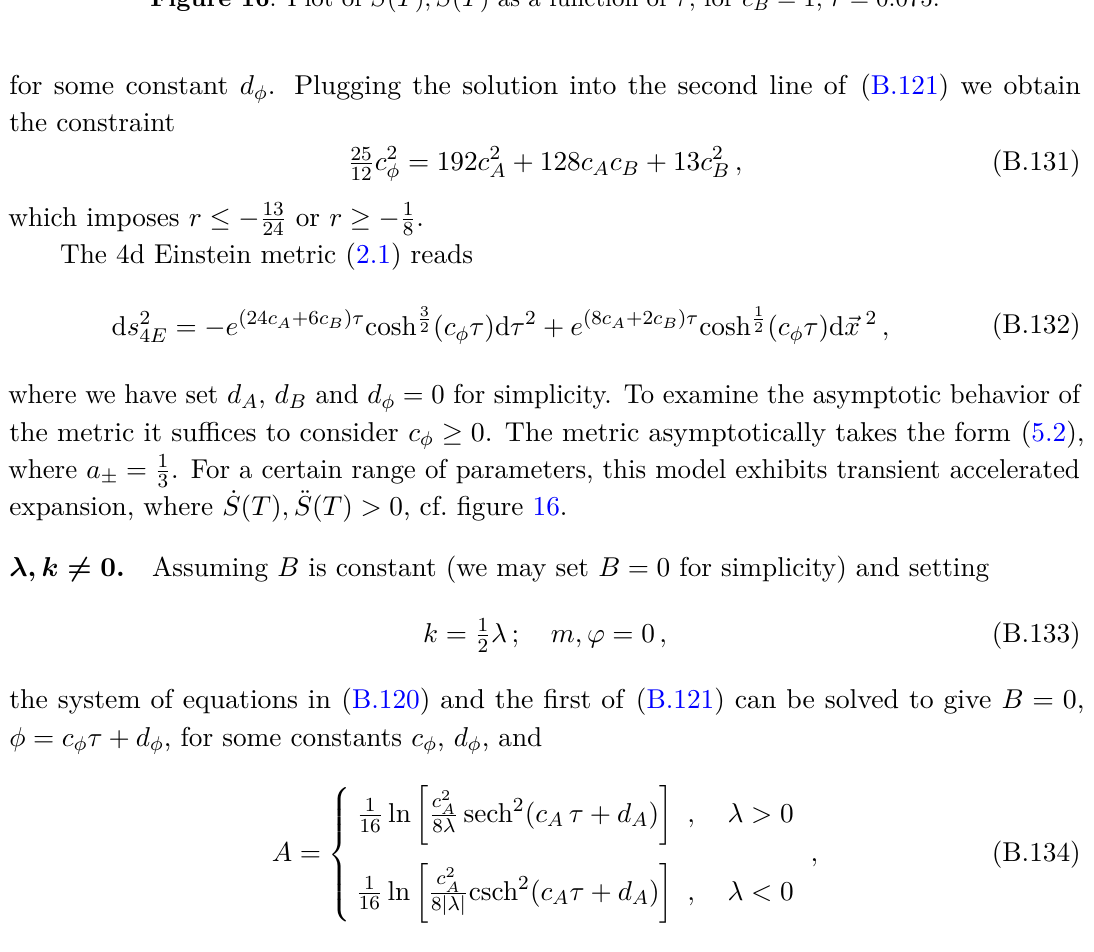
Figure 16 . Plot of